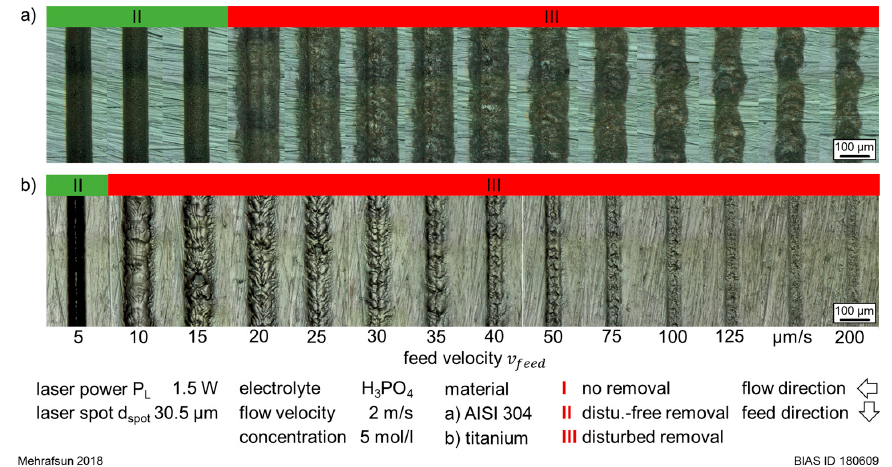
Figure 8. Confocal micrographs of the resulting LCM cavities in ( a ) stainless steel and ( b ) titanium at a laser power P L of 1.5 W in dependence of the used feed velocity.